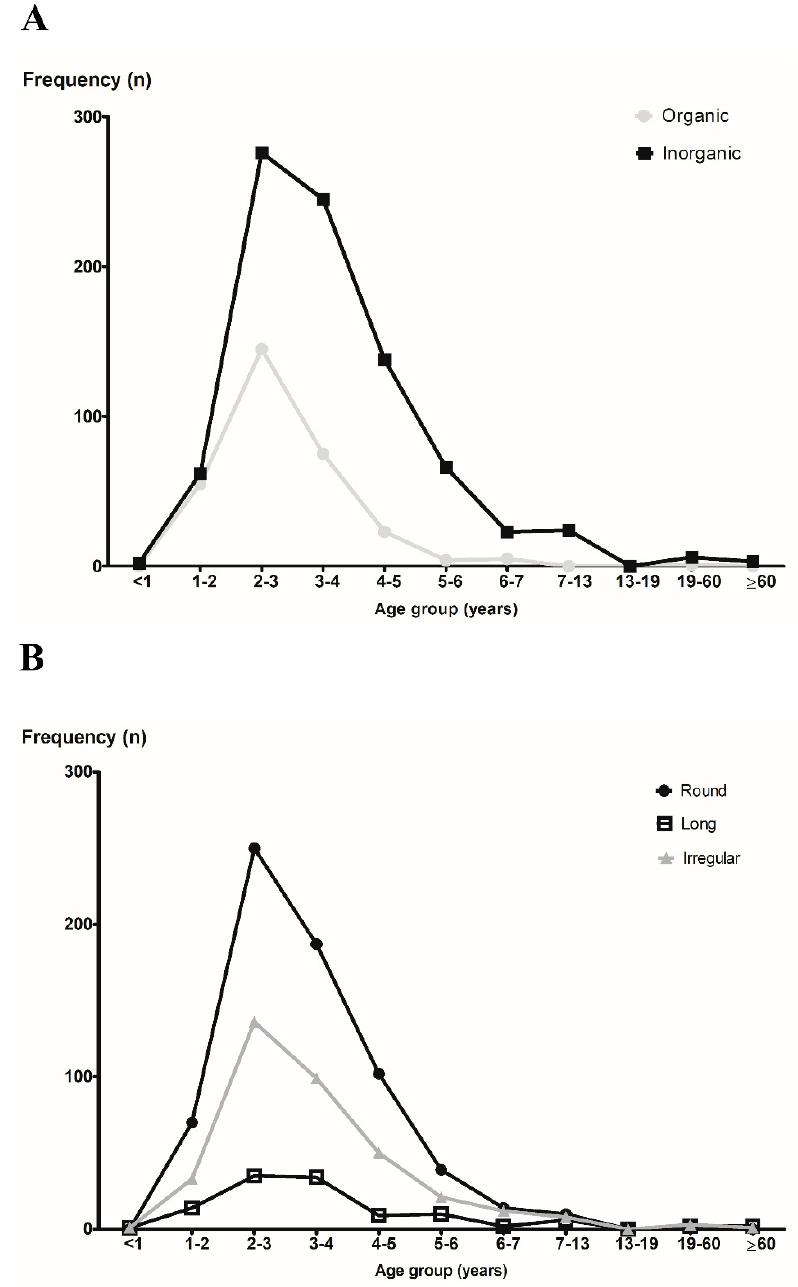
Figure 4. The frequencies of nasal foreign body according to the age group. ( A ) Organic vs. inorganic and ( B ) round vs. long vs. irregular. Table 3. Frequency of nasal foreign bodies according to shape and organic/inorganic